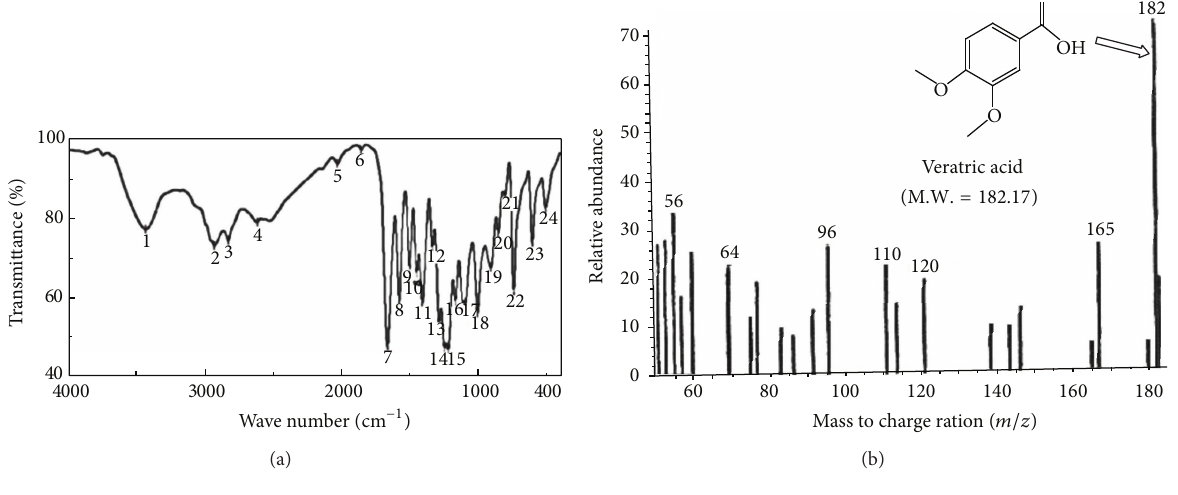
Figure 2: (a) IR spectrum and (b) mass spectrum of veratric